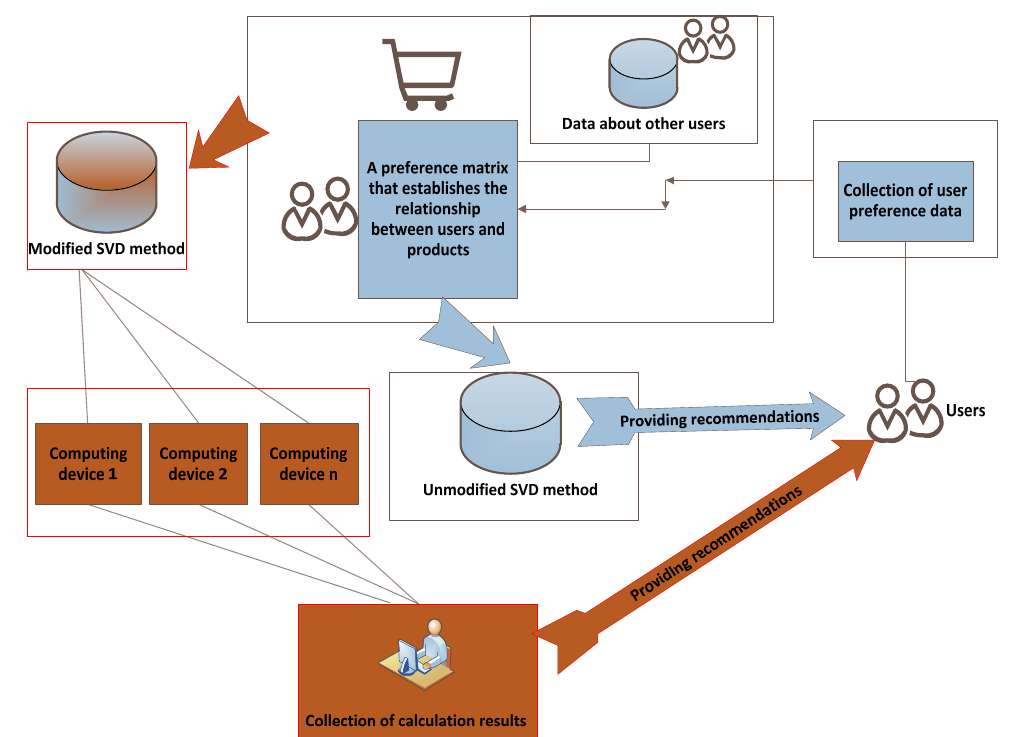
Figure 5. Implementation of the SVD method in a distributed system. Table 1. Dependence of the execution time of distributed calculations of singular data decomposi- tion depending on the number of computational processes.